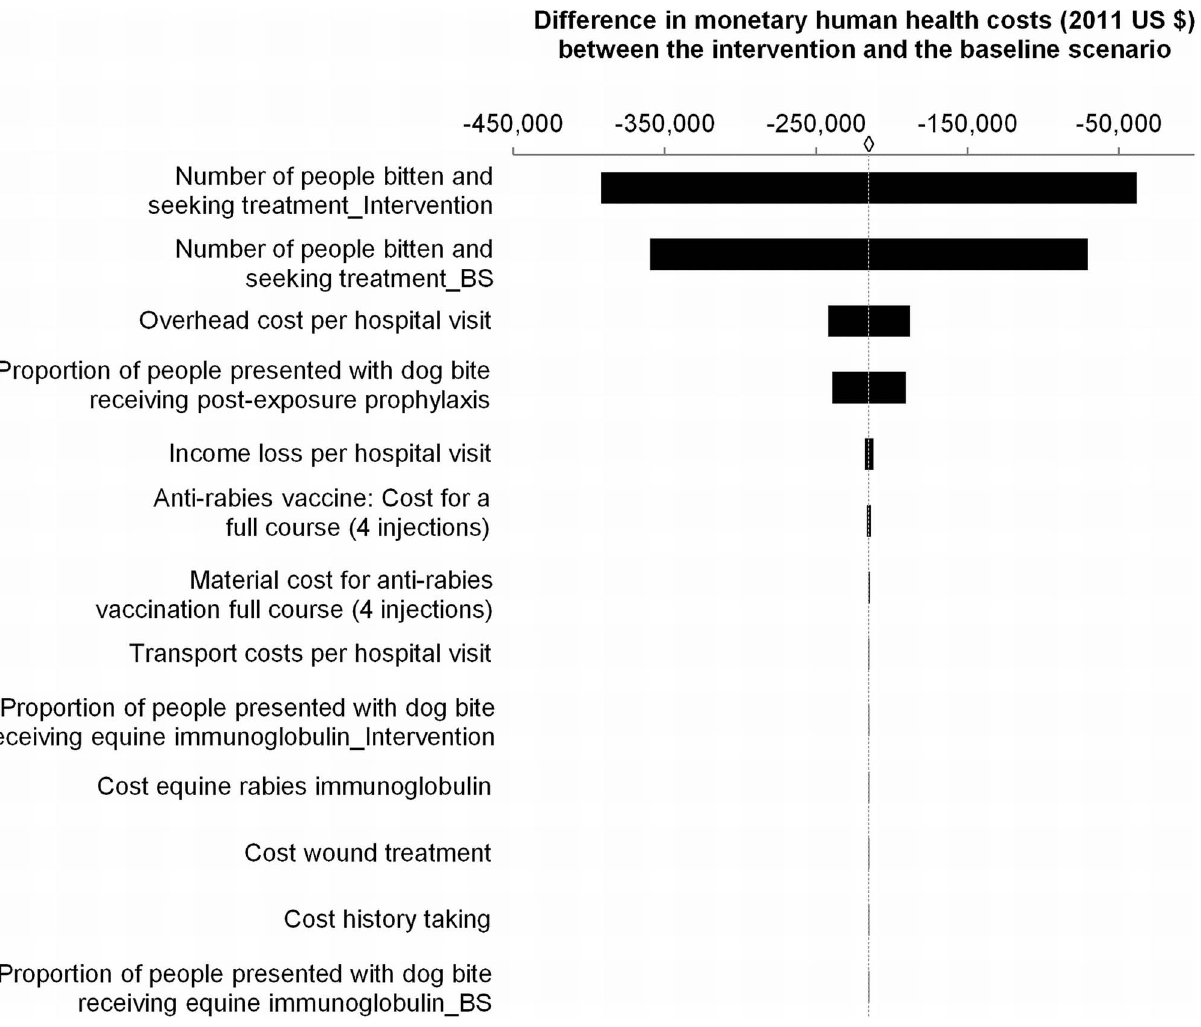
Figure 2. Influence of input variables on monetary health costs. Sensitivity analysis results where distinct input variables were varied by 6 15% and the impact measured on the difference in monetary human health costs (in 2011 US $) between the intervention and the baseline scenario (BS). e =base value=US $ -215,064.